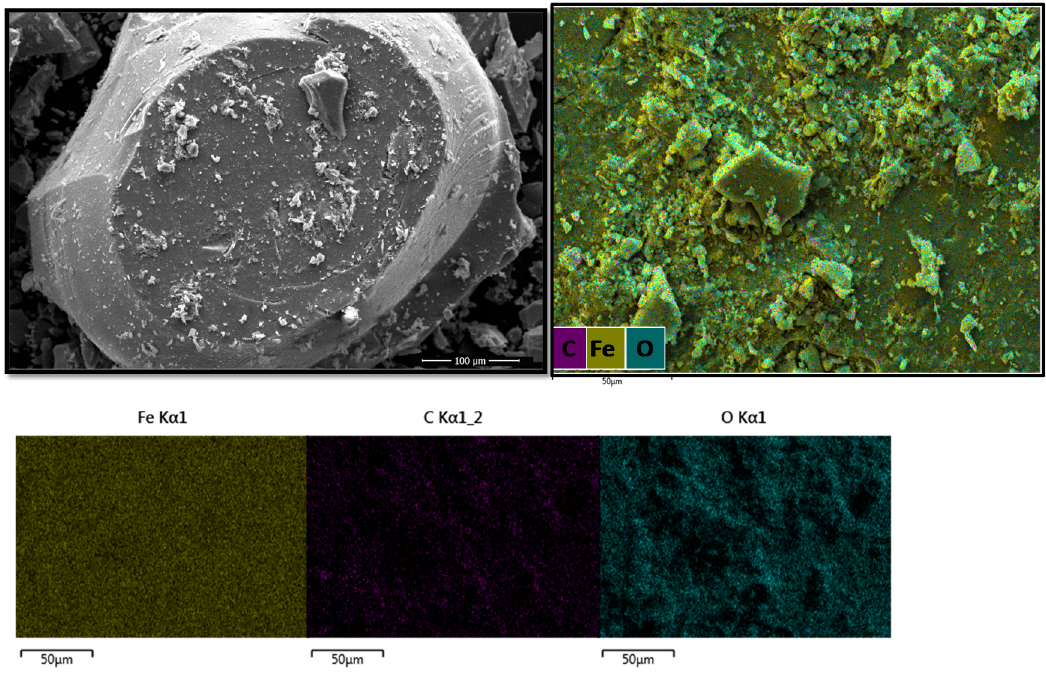
Figure 4. SEM-EDS images of the Fe / FeC solid.